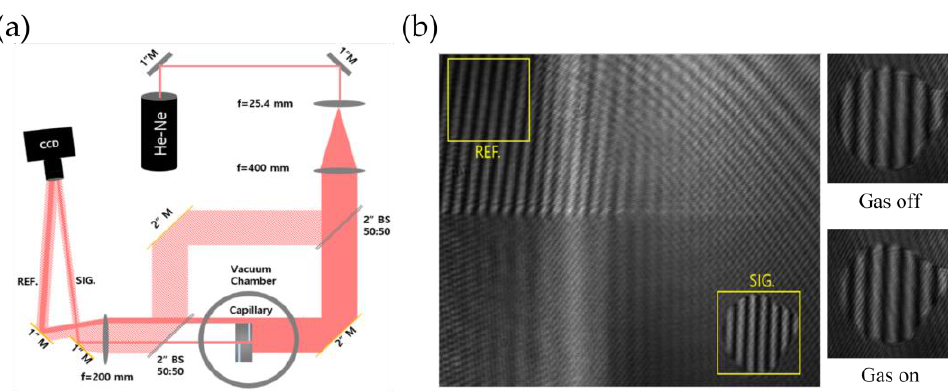
Figure 2. ( a ) Experimental setup for the gas density measurement using a Mach–Zehnder interferometer. To obtain signal and reference images in the single shot image, two mirrors were used for the separate adjustment of the image position. ( b ) The captured image shows the magnified interference patterns, including both signal and reference images.